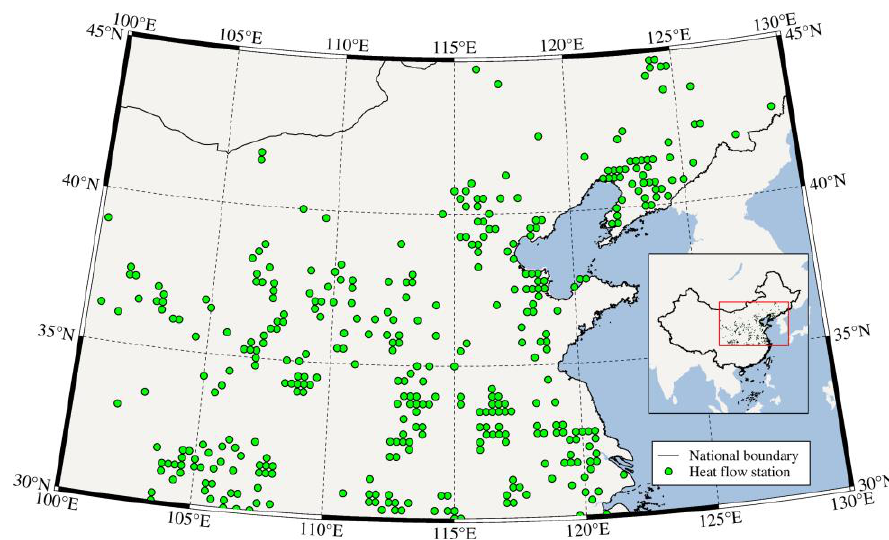
Figure 1. Map of heat flow measurements in North China.